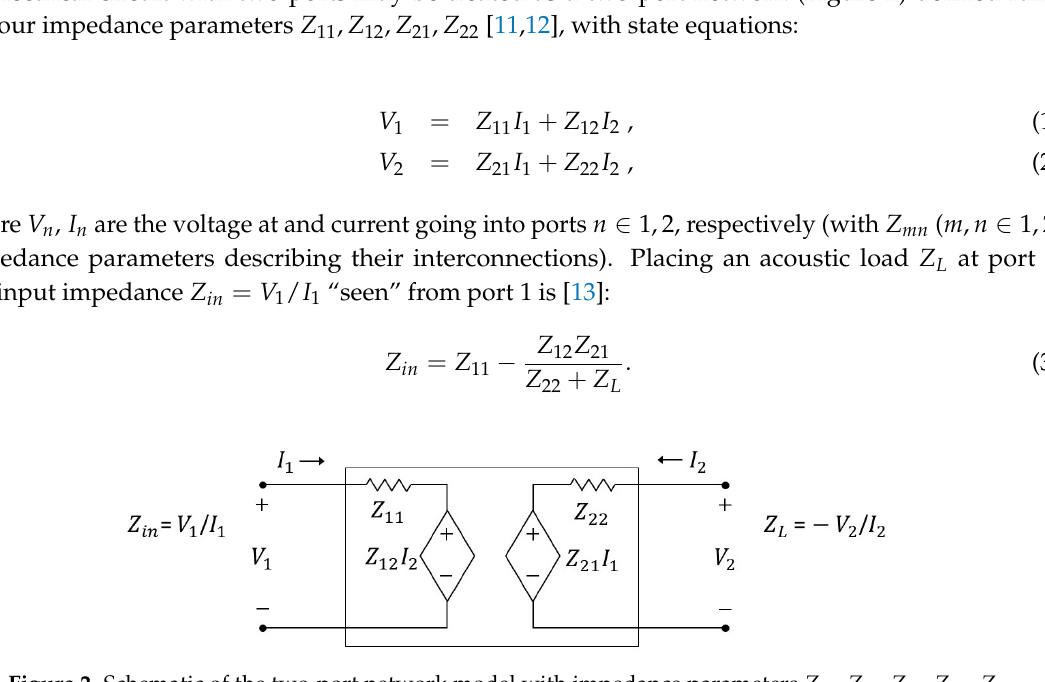
Figure 2. Schematic of the two-port network model with impedance parameters Z 11 , Z 12 , Z 21 , Z 22 . Z L is the load impedance at port 2. The impedance measured at port 1 is Z in